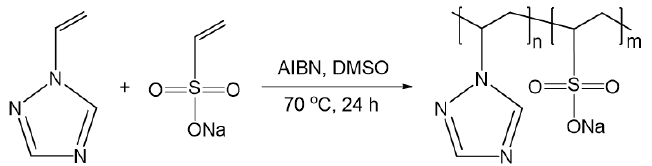
Figure 1. Synthesis of poly(VT-co-Na-VSA).